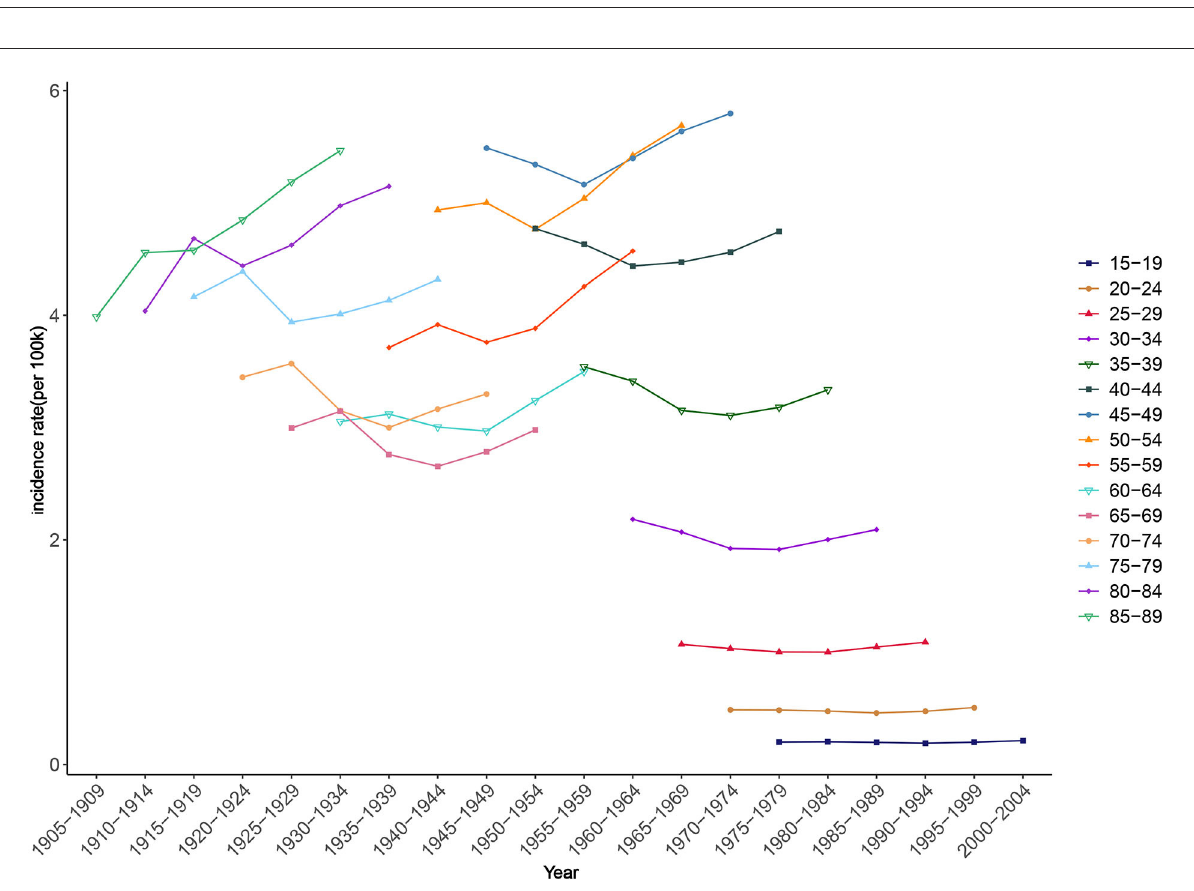
FIGURE8 Cohort trends in NAFLD